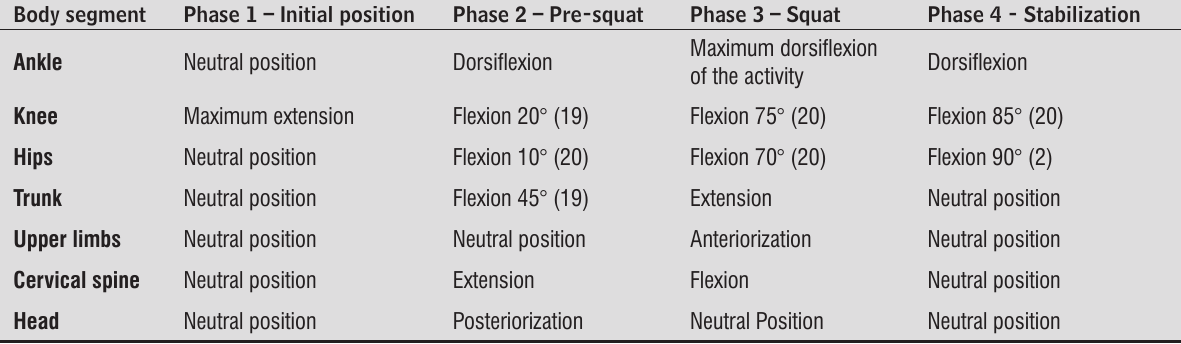
Table 2 - Description of stand-to-sit activity on lateral view